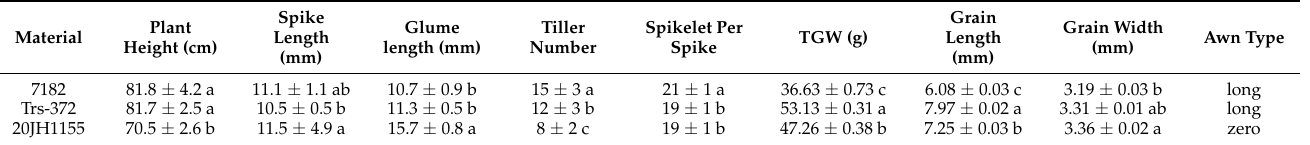
Table 1. Agronomic Traits of 7182, Trs-372, and 20JH11155. Material Plant Height